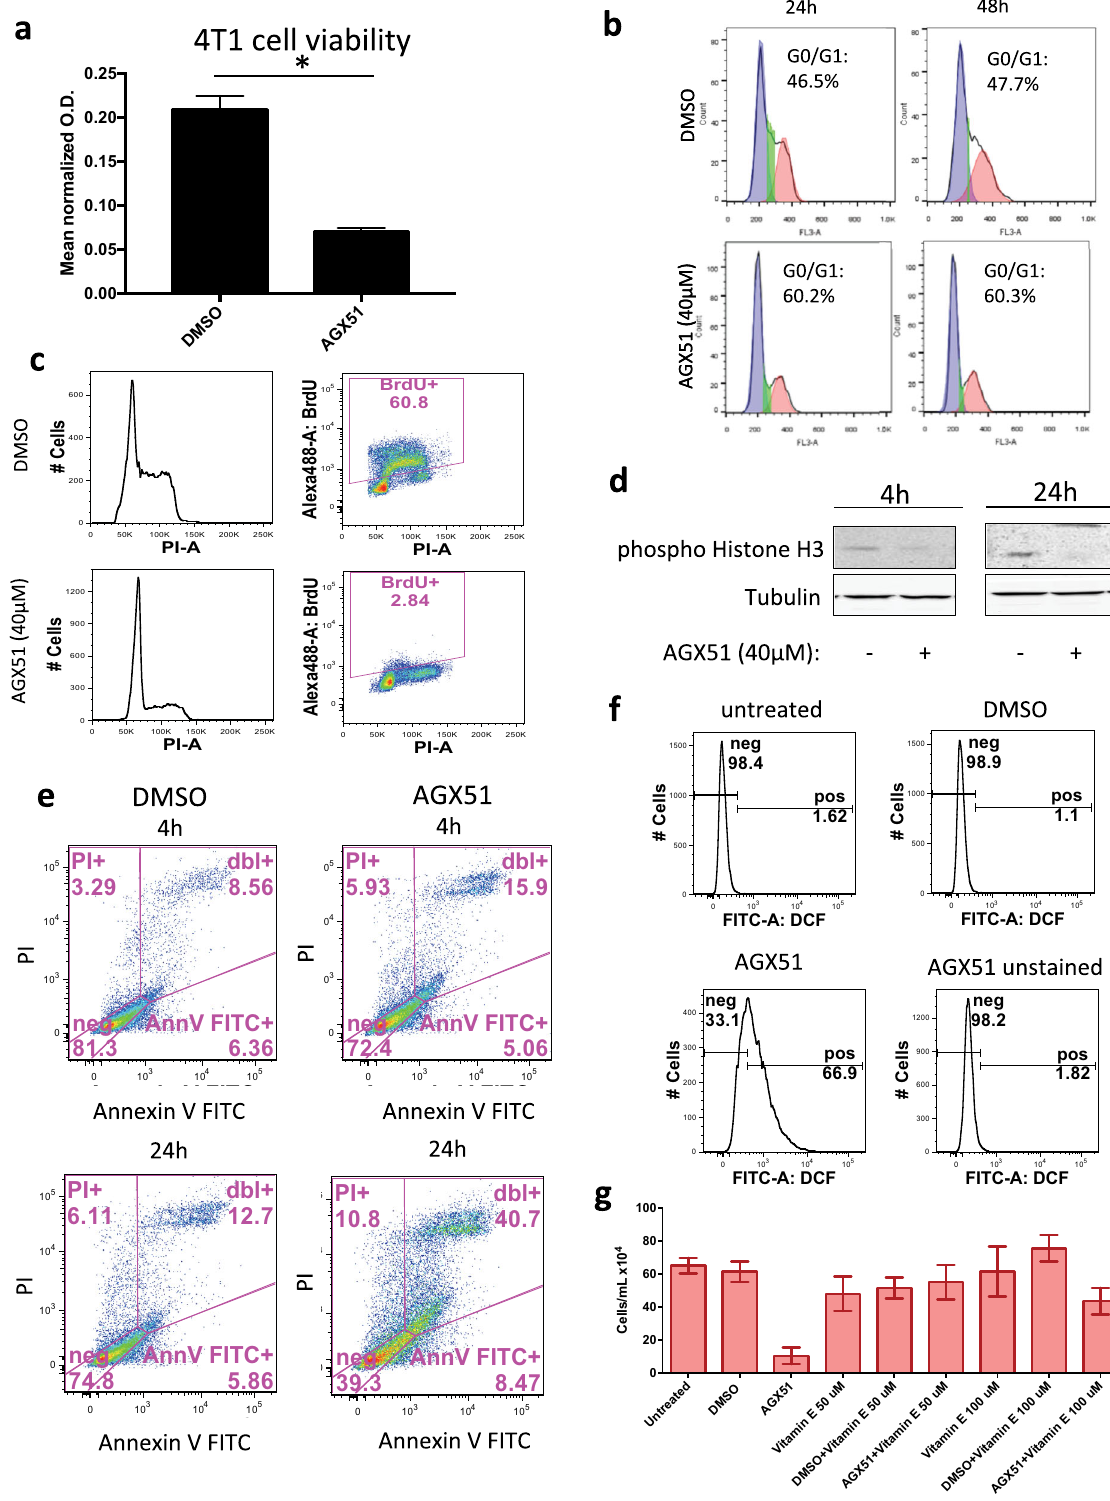
siRNA-mediated ID1 and ID3 inhibition was associated with increased ROS levels 55 and indicate that a main mechanism of AGX51-mediated cell killing is ROS-mediated. We also suggest that the G0/G1 arrest we see prior to cell death may in fact be ROS- mediated as has been observed in other systems 52,53